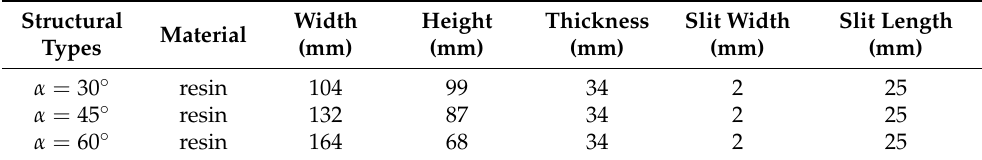
Table 1. Characteristics of the structures used in the